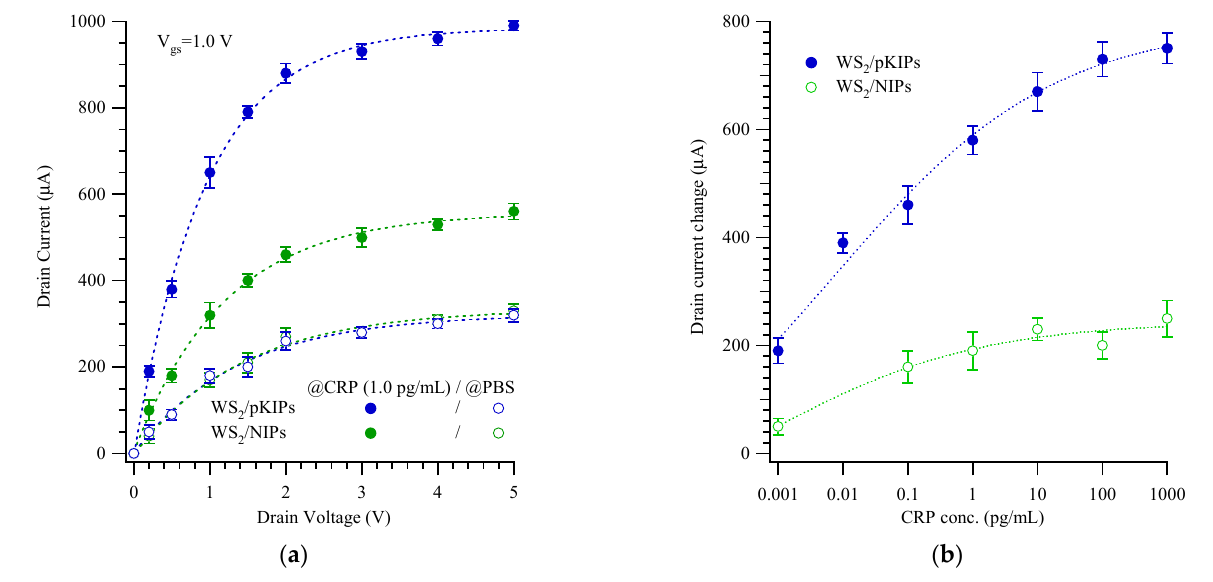
Figure 3. ( a ) Electrochemical response of WS 2 -doped peptide K-imprinted p(AN- co -MSAN)-coated electrodes in CRP and PBS with various drain voltages. ( b ) Calibration curves measured with tungsten disulfide doping peptide K-imprinted p(AN- co -MSAN)-coated extended-gate field-effect transistor. The voltage between drain or gate and source electrodes are 1.5 and 1.0 V, respectively. Table 1. Measurements of CRP in human serum by the WS 2 /pKIPs-coated sensors and ELISA kit. The standard deviations are based on at least three individual measurements.